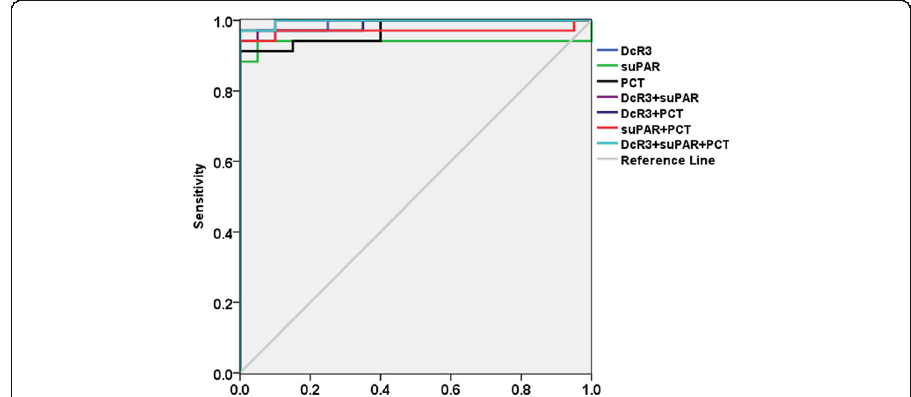
Fig. 4 ROC evaluation of DcR3, suPAR, PCT and DcR3 combined with suPAR, PCT in control group vs. sepsis group. The ROC evaluation was performed at cut-off values recommended by the scientific community of laboratory medicine with 95% CI